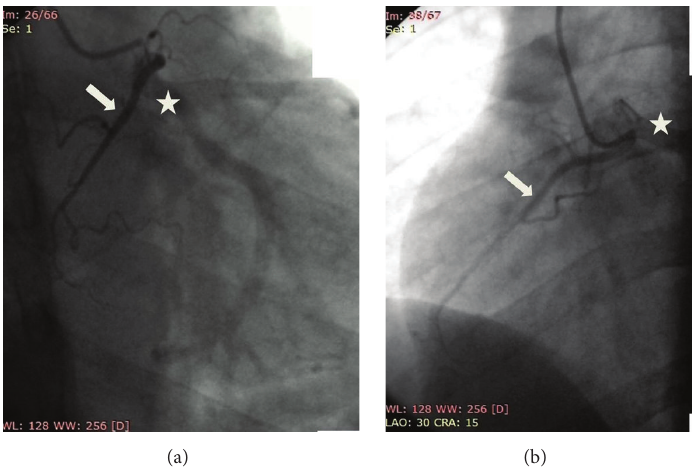
Figure 2: (a) and (b) Coronary angiography (RAO 20 Caudal 20 view and LAO 30 Cranial 15 view) shows RCA (arrow) originated from left sinus and its ostium was adjacent to LCA ostium (star). The caliber of RCA was small and coursed into right ventricles with normal bifurcation.